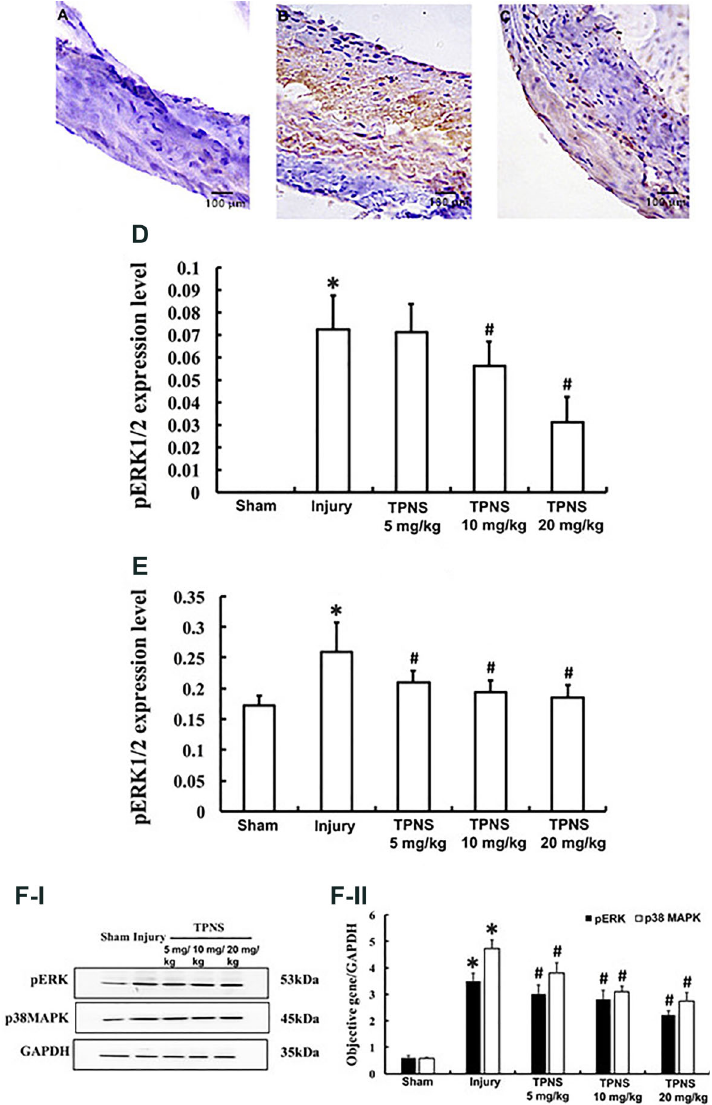
Figure 5. Effects of total Panax notoginseng saponin (TPNS) on the pERK/p38 MAPK signal- ing pathway in the neointima of balloon-injured carotid arteries of rats. A , B , and C show the area of positive pERK immunohistochemistry staining in the sham group, injury group, and high dose (20 mg (cid:3) kg – 1 (cid:3) day – 1 ) TPNS treatment group, respectively. D and E show the levels of pERK 1/2 expression in the neointimal area and media area, respectively, in the sham group, injury group, and TPNS-treatment groups. F - I shows the protein bands of pERK, p38 MAPK, and GAPDH, and F - II shows the objective gene/ GAPDH ratio in the sham group, injury group, and TPNS-treatment groups. Data are reported as means ± SE of 10 rats per group. *P o 0.05 compared to Sham; # P o 0.05 compared to injury (ANOVA and Tukey ’ s HSD post hoc